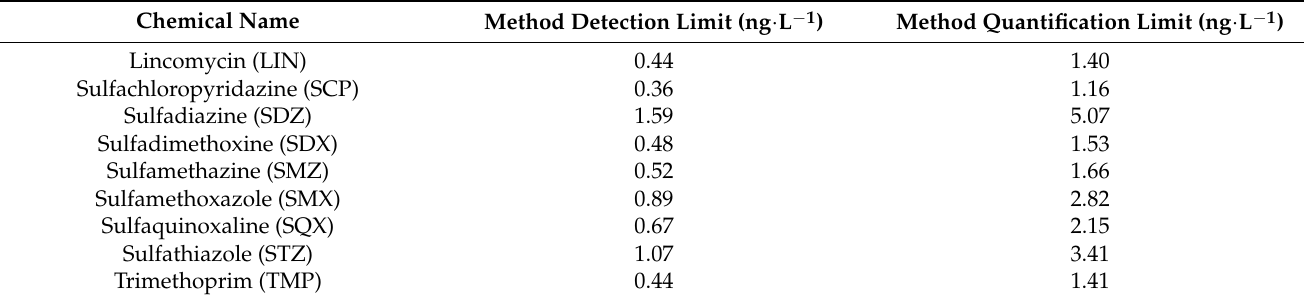
Table A2. Method detection limit (MDL) and method quantification limit (MQL) of the nine target antibiotics. Chemical Name